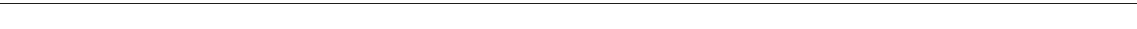
Fig. 6 Homology-directed CCR5 editing after DSB vs. SSB generation. a Diagram of the different DSB-dependent and SSB-dependent genome-editing strategies. pS.Donor R5 and pS.Donor R5.TS have a restriction-fragment length polymorphism (RFLP) fl anked by 400-bp CCR5 sequences ( “ arms ” ). pS. Donor R5.TS has the gRNA R5.1 target site (TS) bracketing its targeting module ( orange boxes ). Combining Cas9 D10A :gRNA R5.2 and Cas9 D10A :gRNA R5.1 complexes generates a targeted DSB by nicking on opposite DNA strands (in cis paired nicking strategy). PAMs boxed sequences; magenta arrowheads , positions of the DSBs and SSBs generated by Cas9 and Cas9 D10A , respectively. b Schematics of the CCR5 genotyping assays. DNA products diagnostic for unedited, edited, and mutagenized CCR5 alleles are indicated. RFLA restriction-fragment length analysis; T7EI mismatch-sensing T7 endonucleases I assay; half arrows , primers c CCR5 genotyping assays. Genotyping of CCR5 sequences by RFLA and T7EI assays in HeLa cells transfected with the indicated plasmid sets. RFLA products speci fi c for unedited and HR-edited CCR5 alleles are identi fi ed by open and closed arrowheads , respectively; T7EI digestion products diagnostic for genetic changes induced at CCR5 by HR and NHEJ are equally indicated. The genomic DNA analyses were performed at 3 days post-transfection. d Comparing genome-editing strategies based on single vs. dual RGNs. HeLa cells were co-transfected with the indicated plasmids